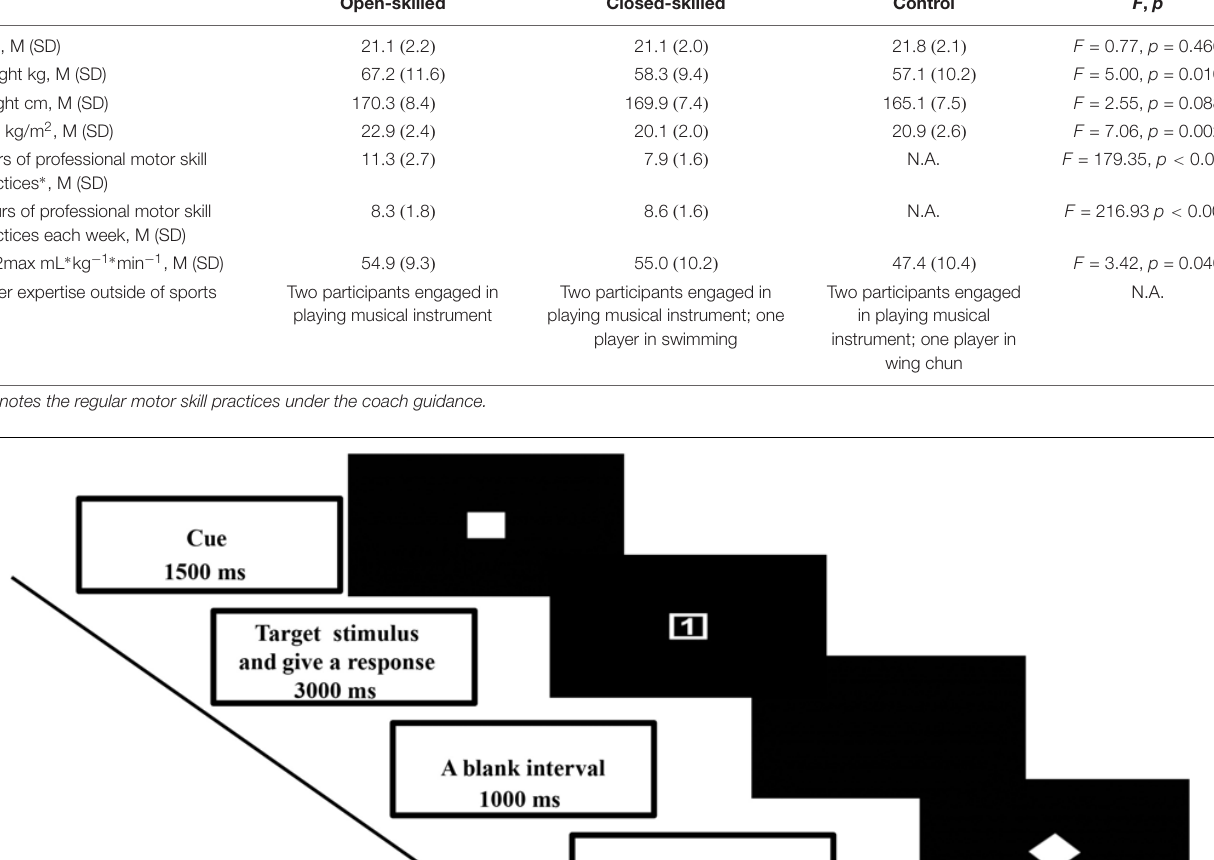
between cue stimulus (square or diamond) and two response selection rules were counterbalanced across participants. Only the 75% validity condition had congruent and incongruent trials. Congruent trials featured the same hollow square or diamond shapes appearing in the cue and target. Incongruent trials were when the shapes displayed in the cue and target differed. Only valid congruent trials in the 75% validity condition were included in the data analyses. Each trial was defined as “repeat” or “switch” depending on the response selection rule. A repeat trial was that the response selection rule was the same as that in the previous trial; whereas that of a switch trial was different from the previous